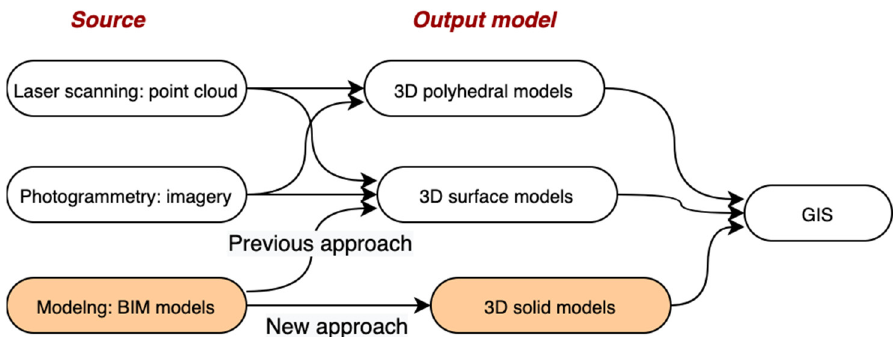
Figure 16. A new approach for using Building Information Modeling (BIM) models in Geographic Information System (GIS).